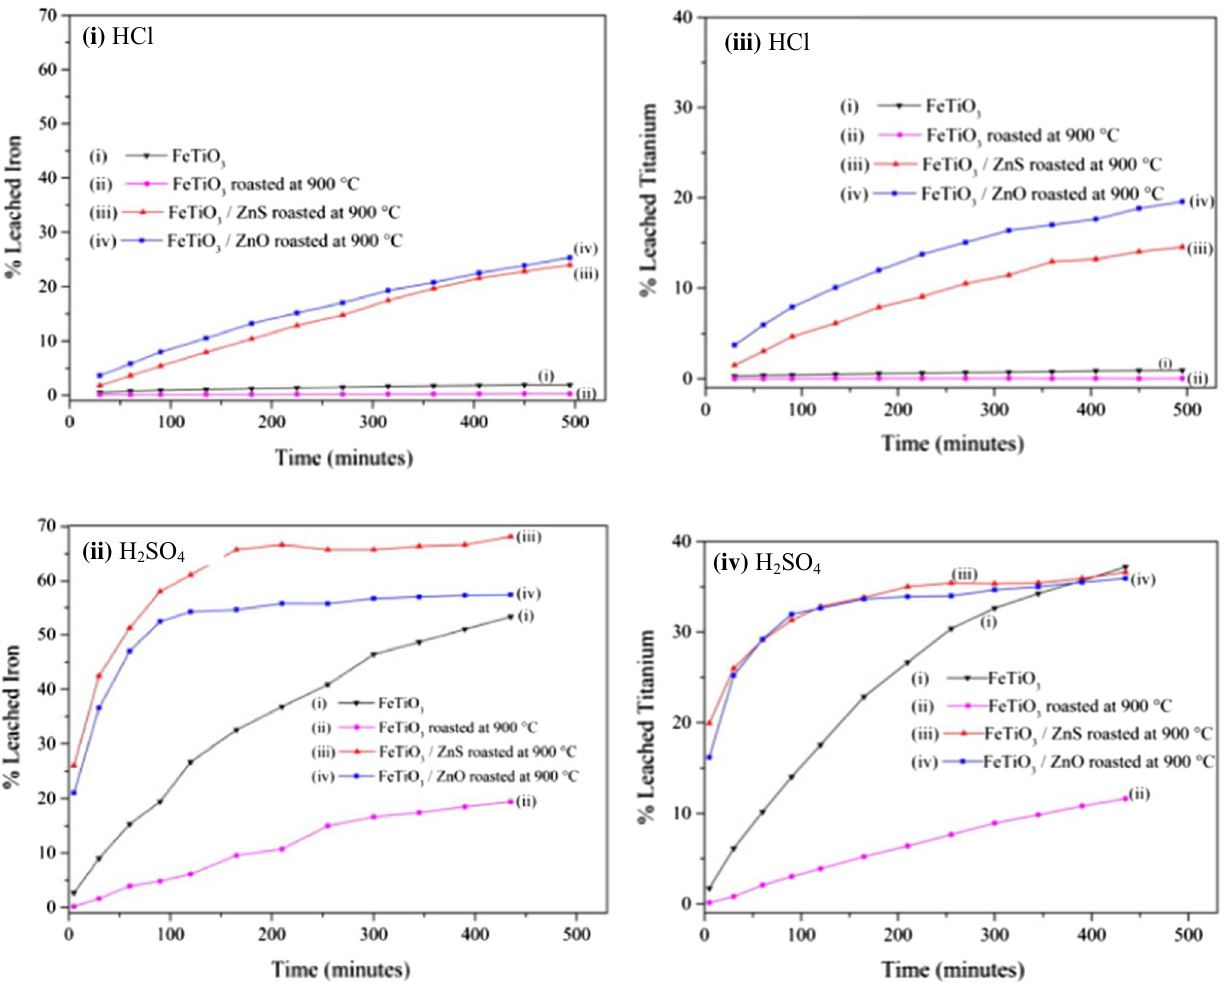
Fig. 6 Total leached of iron (i) and (ii) and titanium (iii) and (iv) in 5 M HCl at 30 °C and in 6 M H Ref.